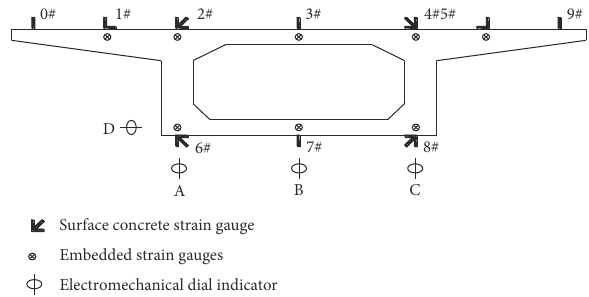
Figure 4. Strain gauges on concrete surface and embedded in concrete and steel bars as well as layout of displacement meters